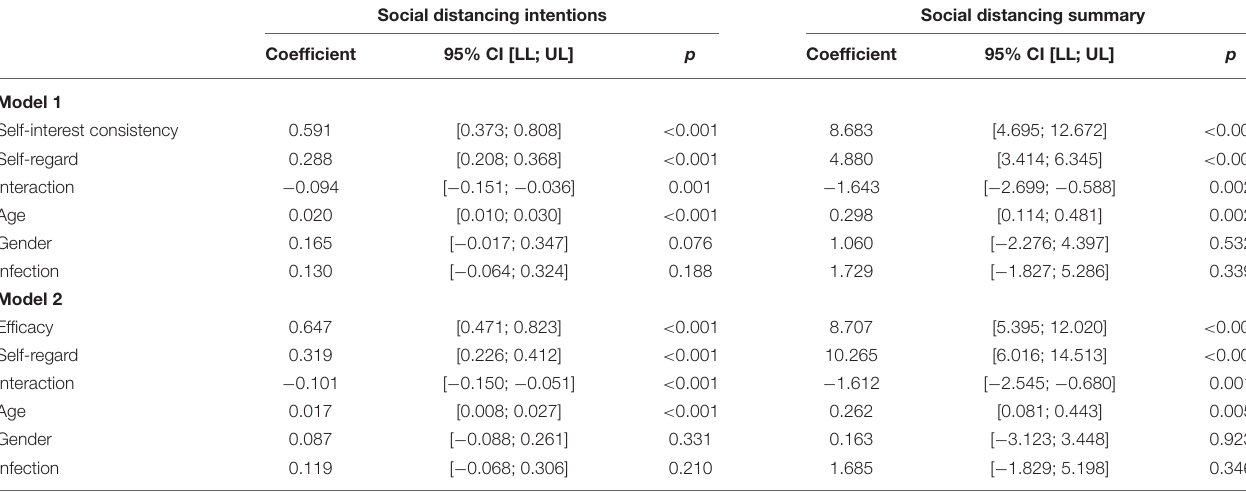
TABLE 2 | Interaction effects of moral self-regard and self-interest consistency (Model 1) and efficacy (Model 2) on measures of social distancing intentions.